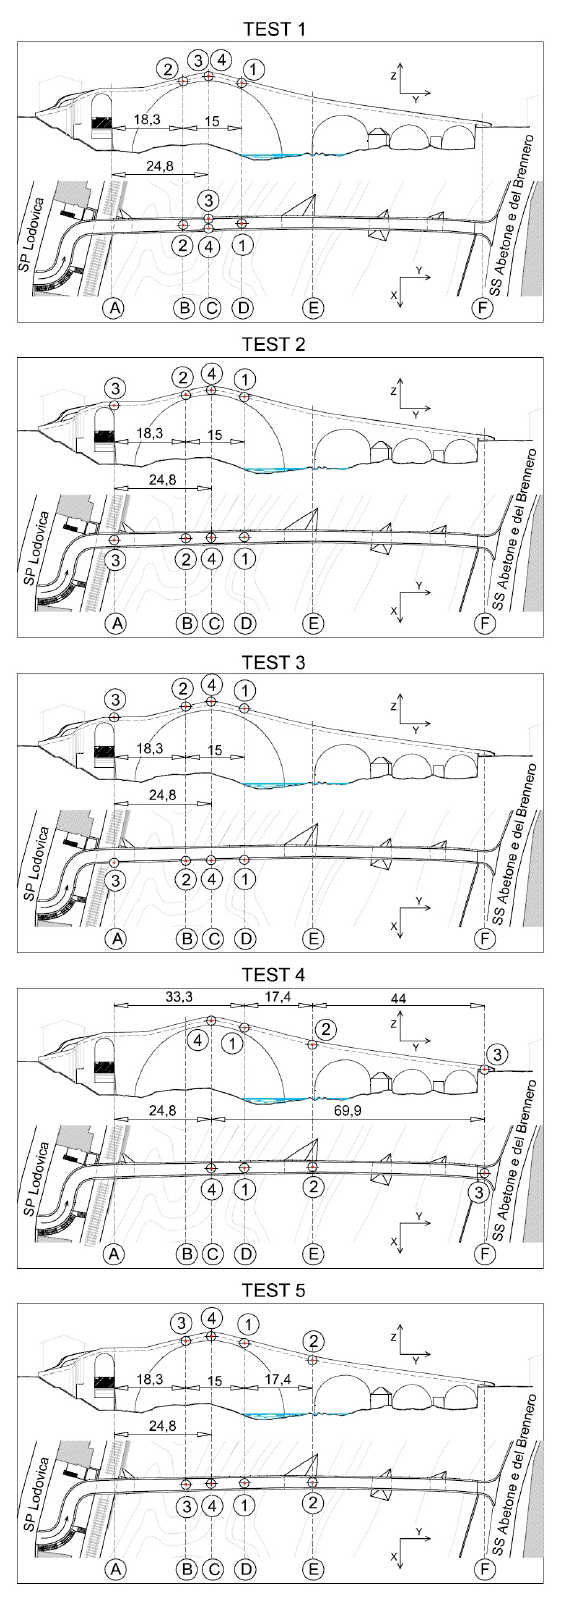
Figure 6. Sensor arrangement for each of the experimental